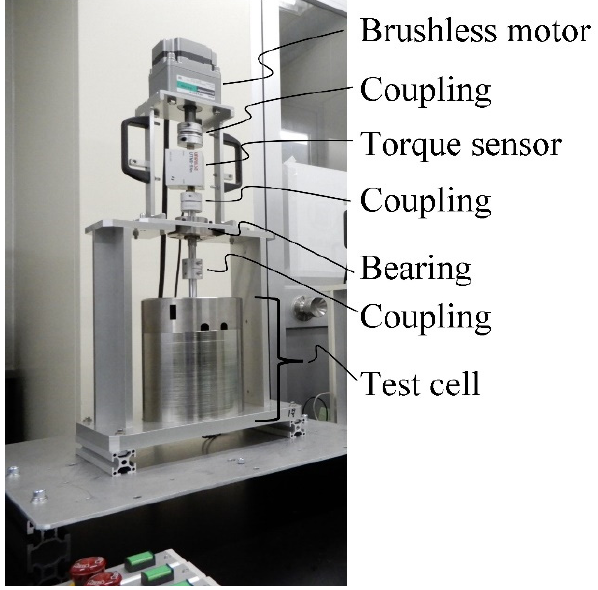
Figure 1. Basic structure of the durability testing machine.